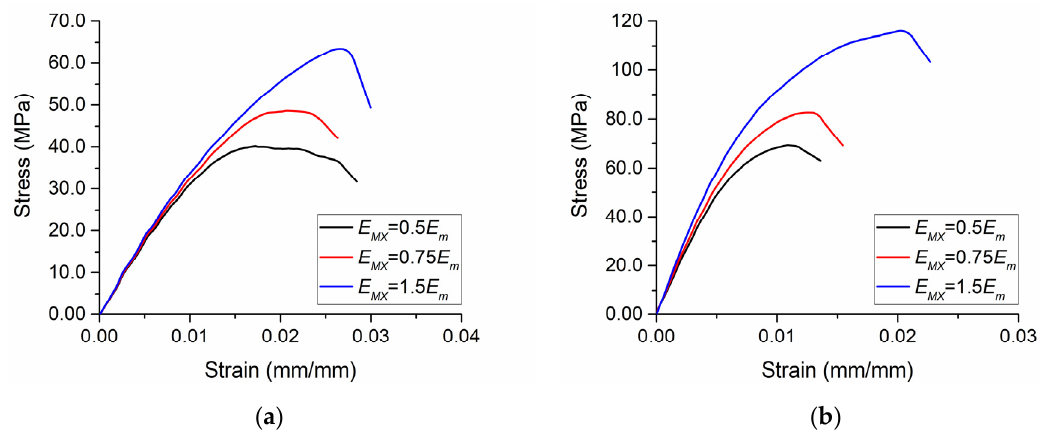
Figure 5. The influence of the MXene/epoxy interface: ( a ) randomly placed MXenes, ρ G = 500, ρ MX = 125, f G = 0.1%, and f MX = 1.6%; ( b ) aligned MXenes, ρ G = 500, ρ MX = 125, f G = 0.1%, and f MX = 6.4%.